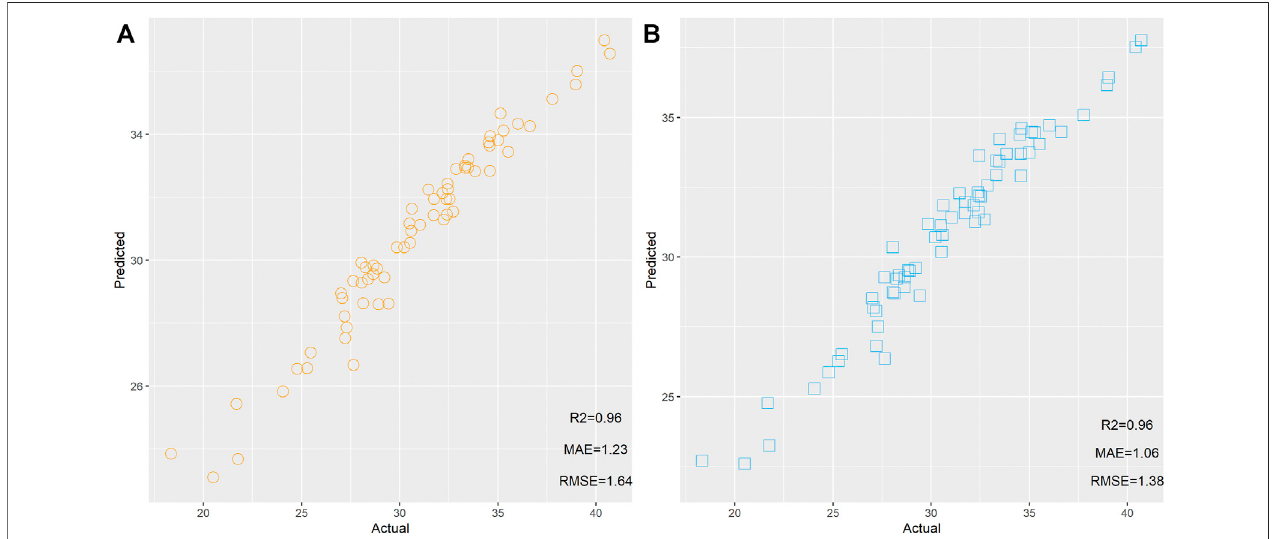
FIGURE 2 | Scatter plot of the predicted age and actual age by random forest based on 274 (A) and 14 mRNAs (B) .